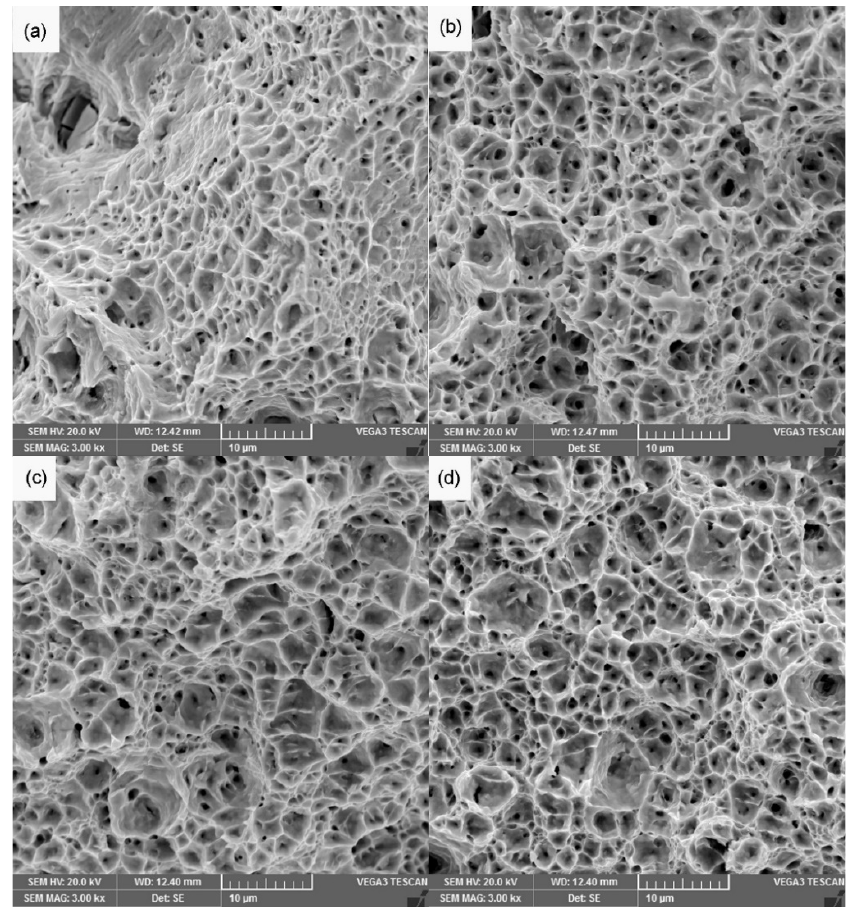
Figure 10. Room temperature tensile fracture morphology of ( a ) 718 base metal, ( b ) F22 base metal, ( c ) 718-F22 joint, and ( d ) 718-F22 joint with 625 interlayer.